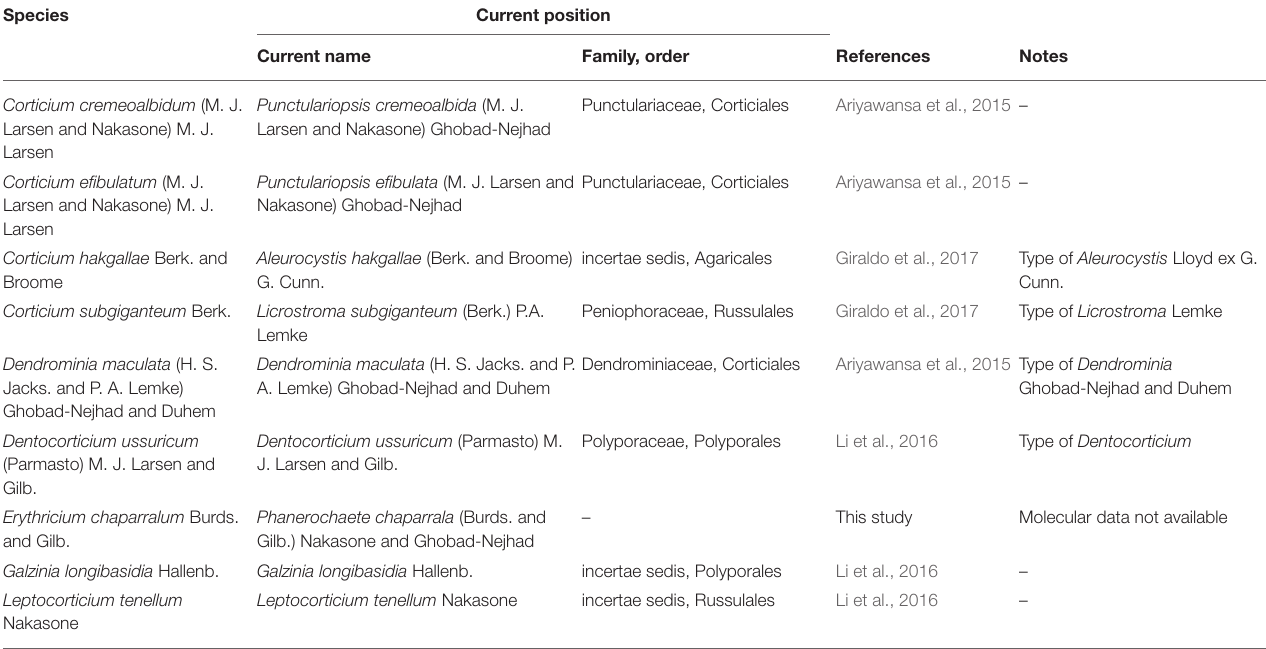
TABLE 3 | Summary of some important taxa excluded from Corticiaceae based on our type/authentic material